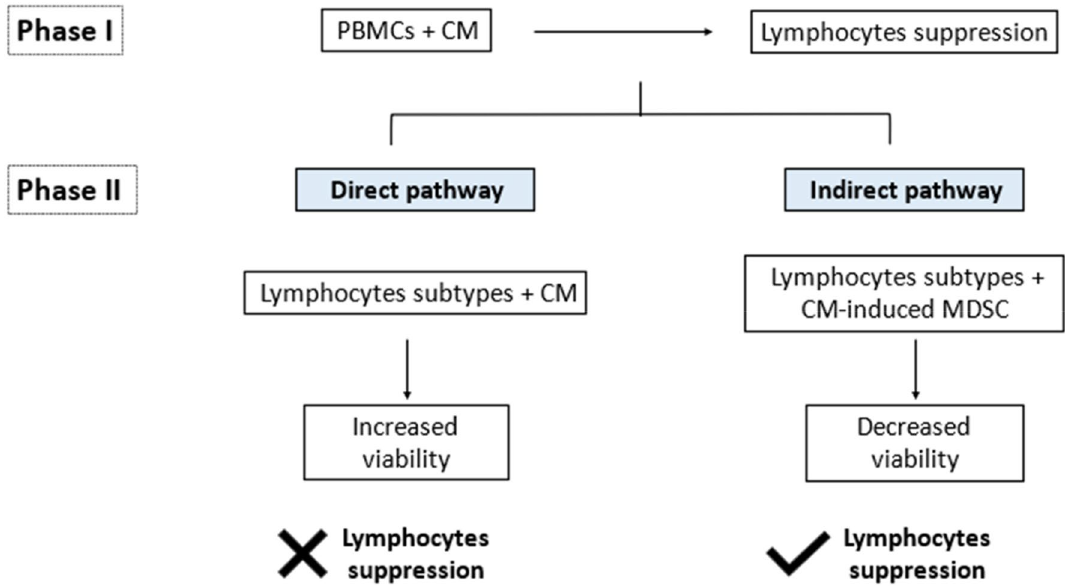
Figure 6. The summary of phase I and phase II. The study has been divided into two phases. Lymphocyte suppression was observed in the first phase. Whereas in the second phase, lymphocyte suppression was observed only in the indirect